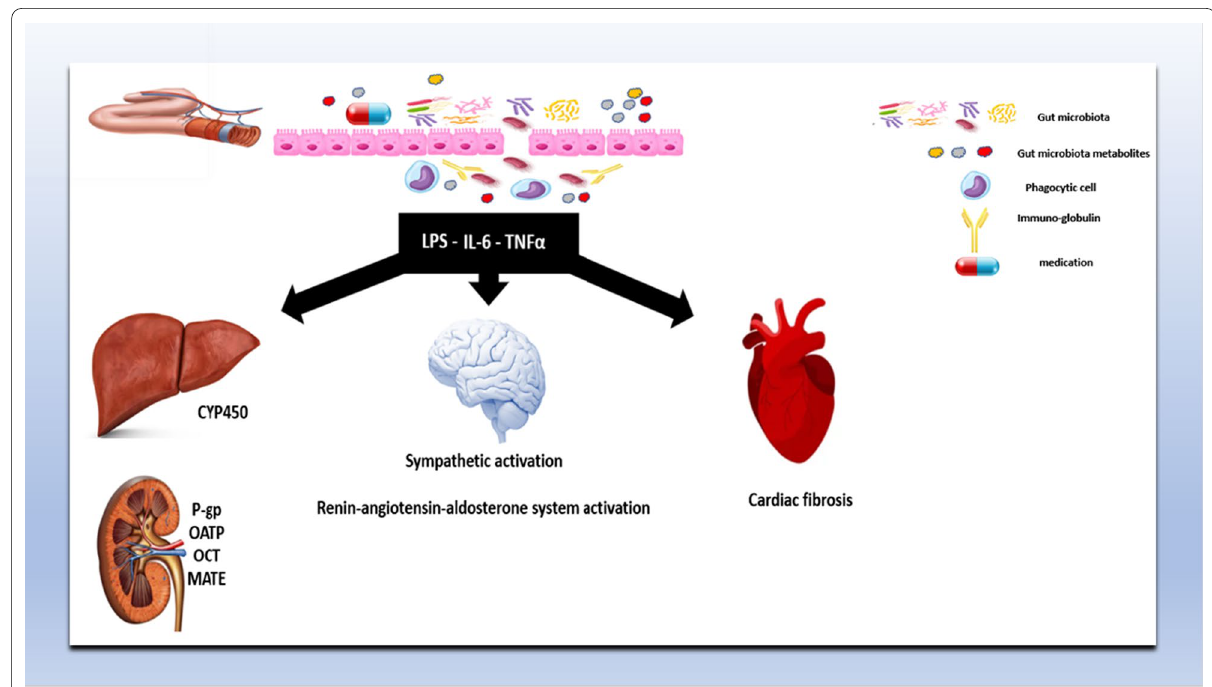
Fig. 1 The role of gut microbiota in: the pathogenesis of cardiac arrhythmia and the pharmacokinetics of drugs used in the management of arrhythmia. IL interleukin, LPS lipopolysaccharide, TNFα tumor necrosis factor